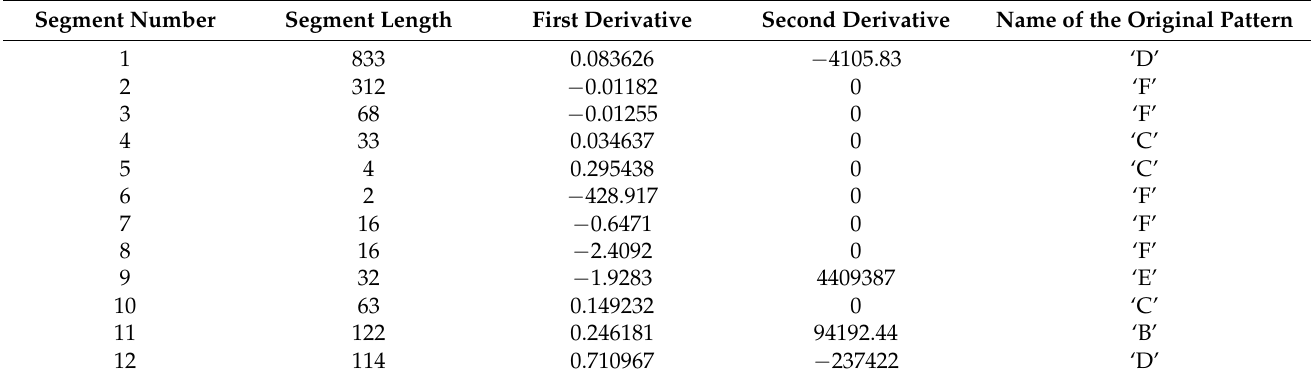
Table 3. Sample of data stored in the library.